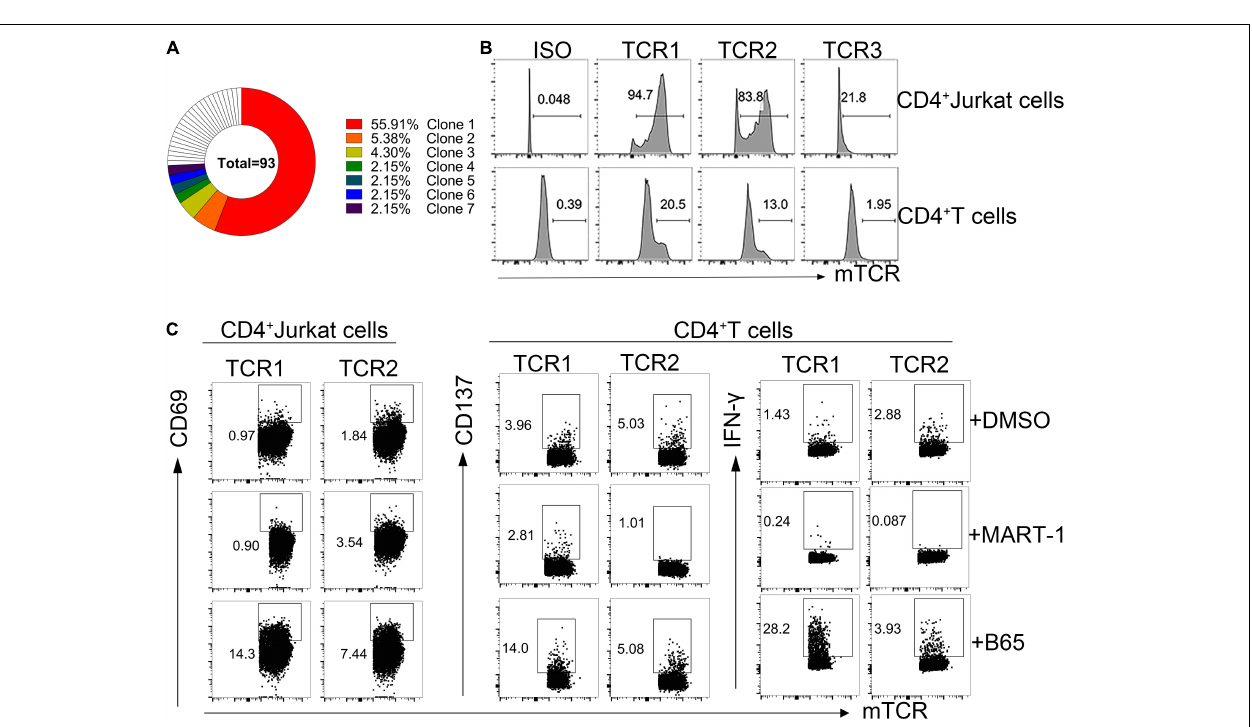
FIGURE 4 | Reactivity of B65-specific CD4 + TCR-T cells to B65 peptide in vitro . (A) MGT/V-Quest was used to analyze the TCR repertoire of B65-specific CD4 + T cells. Different colors mean different TCR clones. White indicates unique clones. (B) The expression of TCR in CD4 + Jurkat or CD4 + T cells was detected by FC. (C) TCR-transduced CD4 + Jurkat or CD4 + T cells were cocultured with PBMCs plus B65 or MART-1 (negative control) for 6 or 24 h, respectively. The level of activation marker of CD69 or CD137 and IFN- γ in TCR-transduced CD4 + Jurkat or CD4 + T cells was determined by FC, respectively. FC, flow cytometry; IFN- γ , interferon- γ ; TCR, T cells receptors; PBMCs, peripheral blood mononuclear cells; MART-1, melanoma-associated